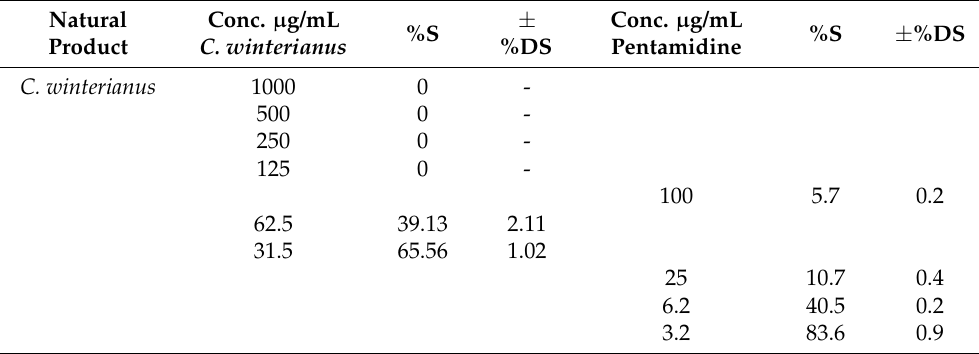
Table 3. Survival of the promastigote L. brasiliensis treated with the essential oil of C. winterianus .